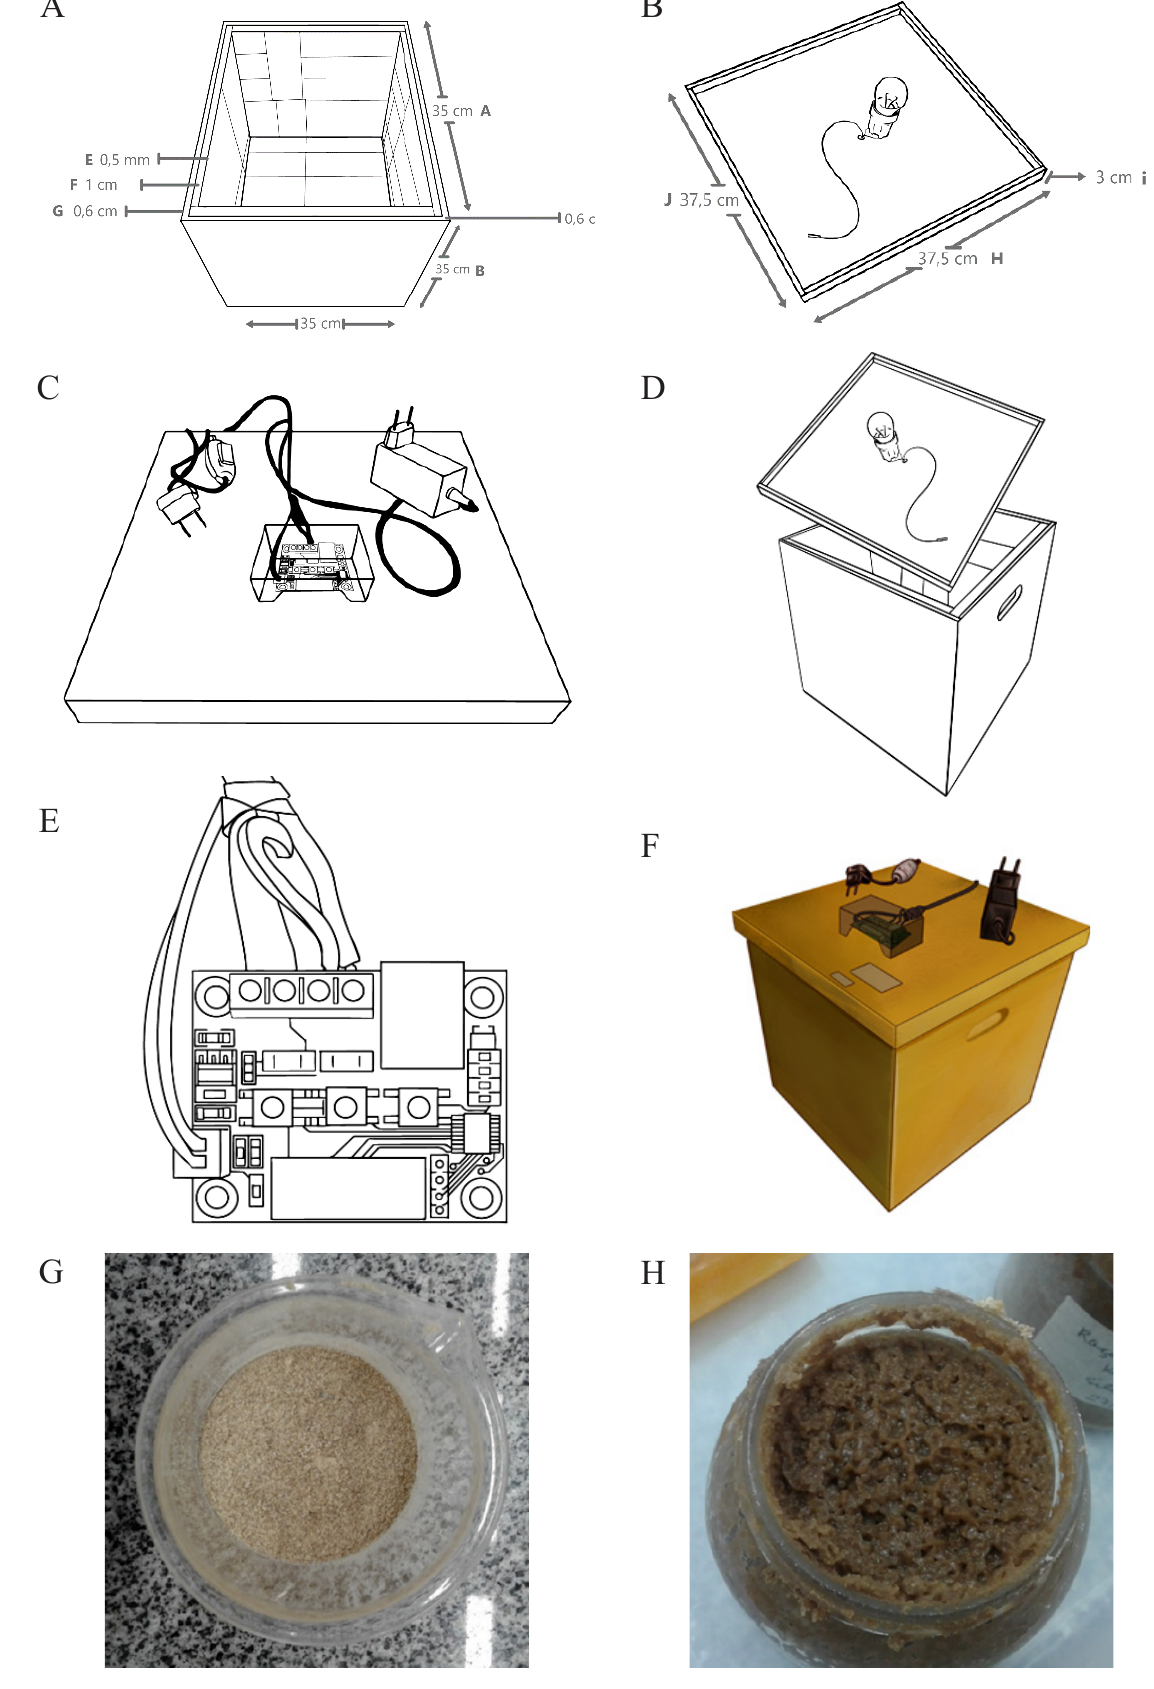
Fig 1 . Details of the constitution of the artisanal incubator: A. Styrofoam and polyethylene lined box; B. cover with socket and lamp; C. thermostat and socket; D. Inner face of box and lid; E. digital thermostat; F. ready incubator; G. diet before fermentation and H. fermented